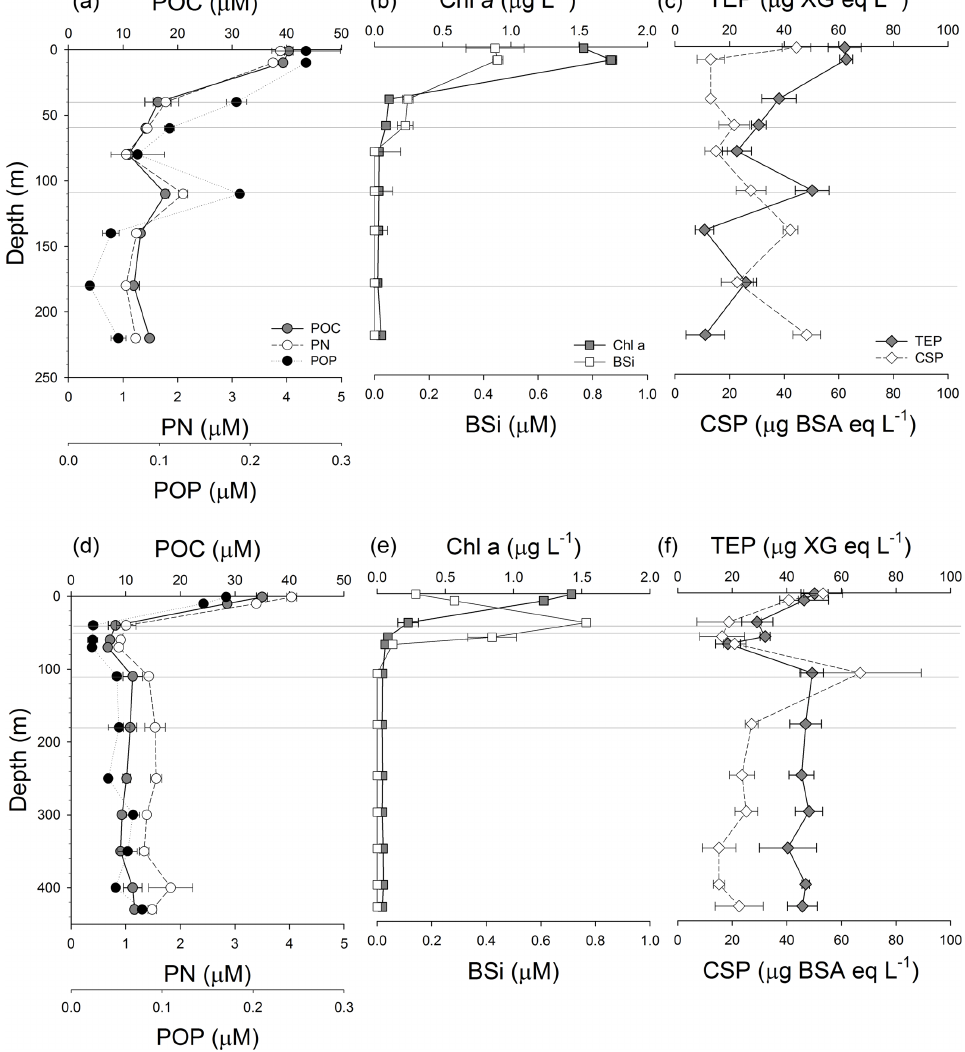
Figure 3. Vertical profiles of the concentration of particulate organic carbon (POC), particulate nitrogen (PN) and particulate organic phos- phorus (POP) in GB (a) and LD (d) ; vertical profiles of the concentration of chlorophyll a (Chl a ) and biogenic silicate (BSi) in GB (b) and LD (d) ; and vertical profiles of the concentration of transparent exopolymeric particles (TEPs) and Coomassie stainable particles (CSPs) in GB (c) and LD (f) . Grey lines as Fig.